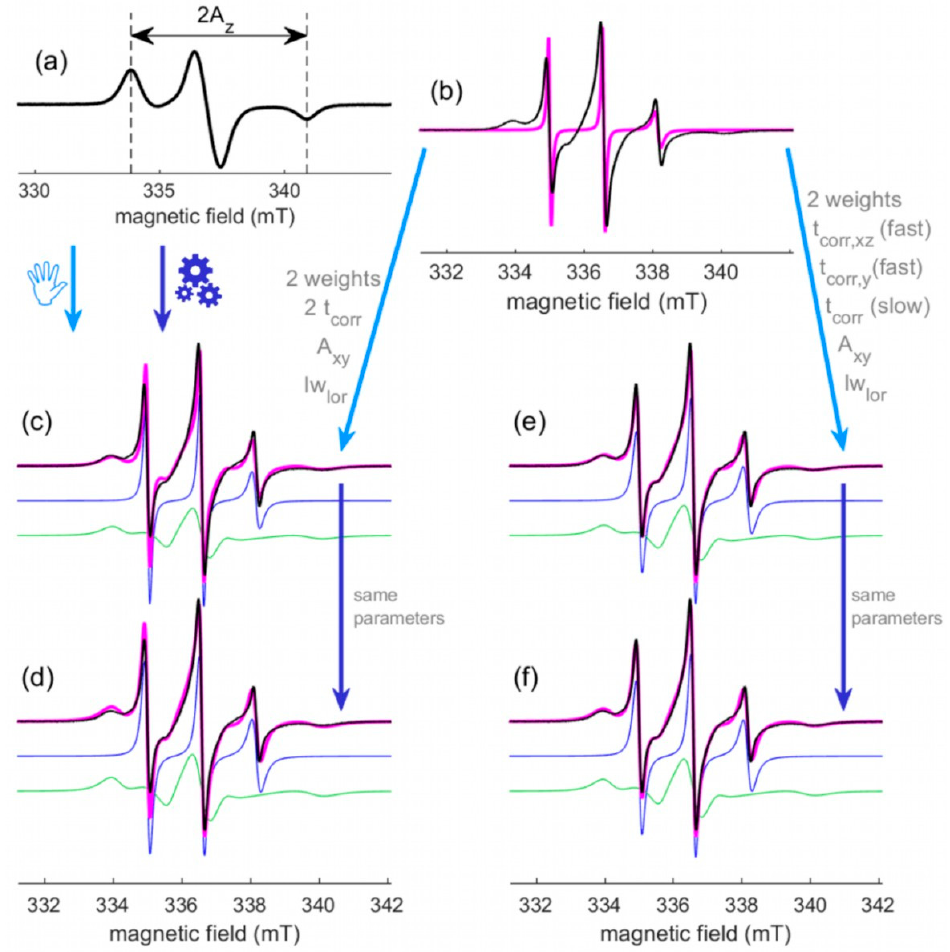
Figure 6. Different steps during the simulation and fitting process for sample 2. ( a ) The experimental spectrum of the frozen solution (115K) to extract 2A z from the positions of the two outer lines (A z = 3.54 mT). ( b – f ) Superpositions of the experimental spectrum (black traces) recorded at room temperature with a calibrated magnetic field and the different simulations (magenta traces) of the fitting procedure. The simulations in ( c – f ) result from the sum of the spectra of a fast component (blue traces) and a slow component (green traces). The simple arrows indicate the sequence of intermediate simulations. Light and dark blue arrows stand for manual and automatic fitting, respectively. The adjusted parameters are indicated in grey. The parameters of these simulations are given Table 2. Table 2. Variable parameters used to obtain the simulations shown in magenta Figure 6b–f for sam- ple 2. The fast component and the slow component refer to the blue and green traces shown Figure 6, respectively. The other fixed parameters are: Az = 3.54 mT, g x = f(A z ) = 2.0087, g y = 2.0061 and g z = 2.0022 at 9.45 GHz.